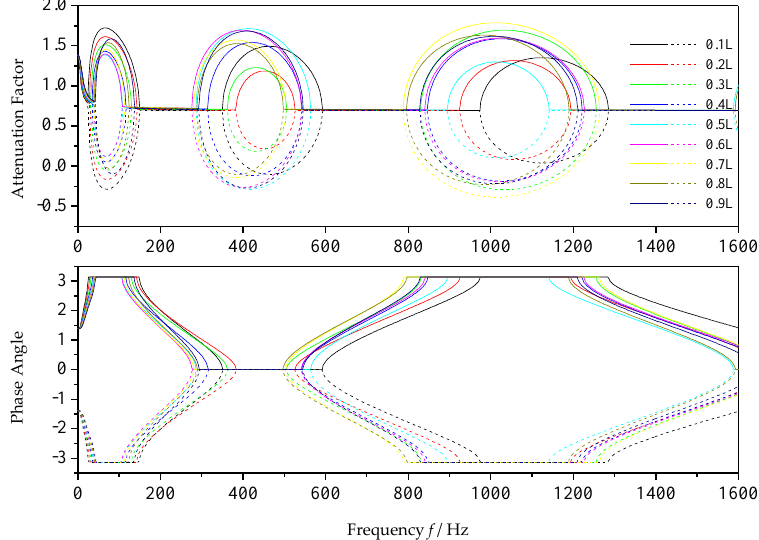
Figure 8. Numerical propagation constants derived from different crack locations.